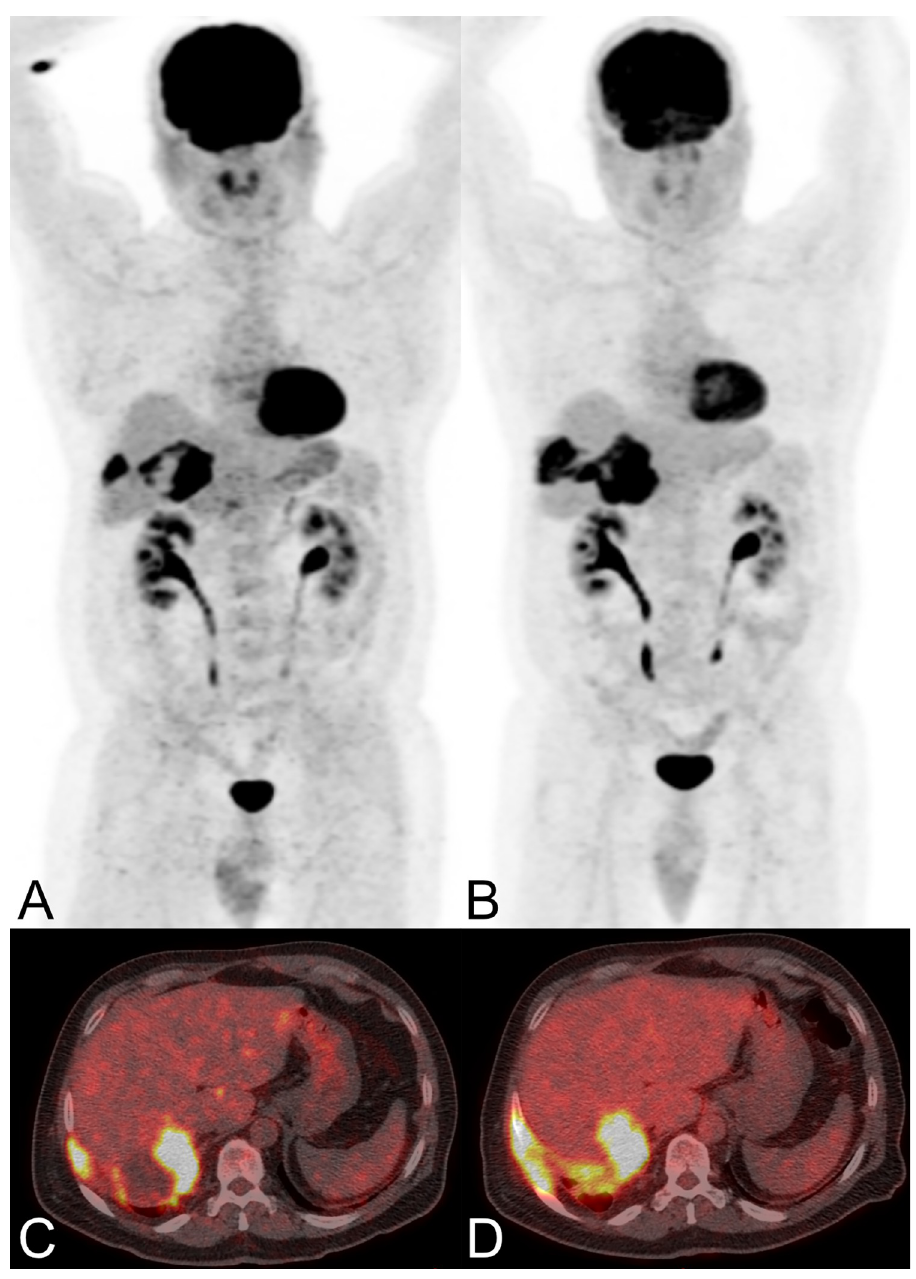
Fig 2. Two PET/CT scans performed in a male patient with a hepatic manifestation of alveolar echinococcosis involving the chest wall. The patient (patient 09 in Table 2 ) was 55 years old in 2008 (maximum intensity reconstructions of PET (A) and fused PET/CT images (C)), and 58 years old in 2011 (B and D) and was treated with mebendazole from 2001 to 2011. The follow-up PET/CT 2011 (B and D) documented progression of disease with increasing involvement of the chest wall as compared to the PET/CT from 2008 (A and C) (EgHF AU increased from 34 to 35, SUVratio liver was continuously high at 4.6), and therapy was subsequently changed to albendazole. The patient died in 2017 of unknown